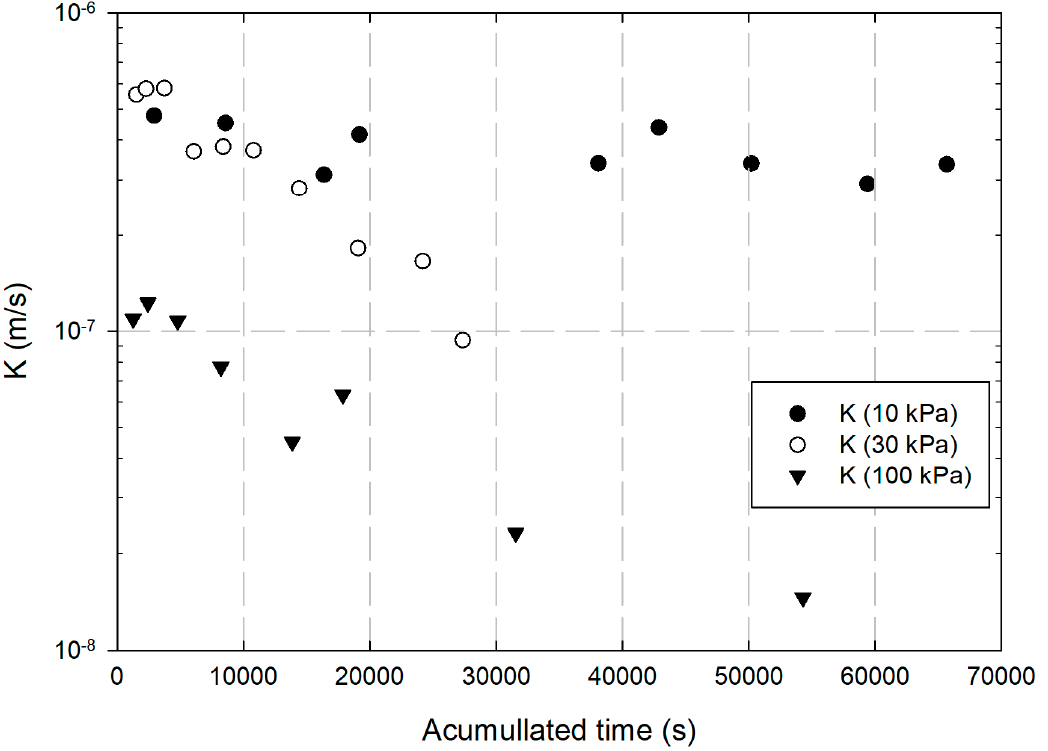
Figure 3. Permeability variation with elapsed time under di ff erent pressures